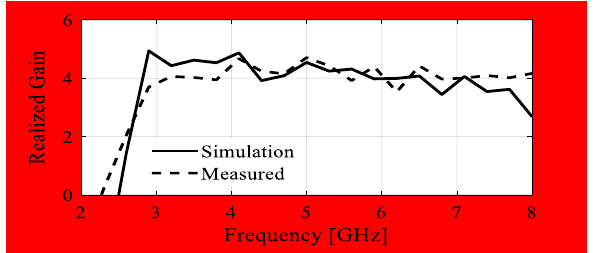
Figure 15. Simulated and measured realized gain of the final design (Example 3).